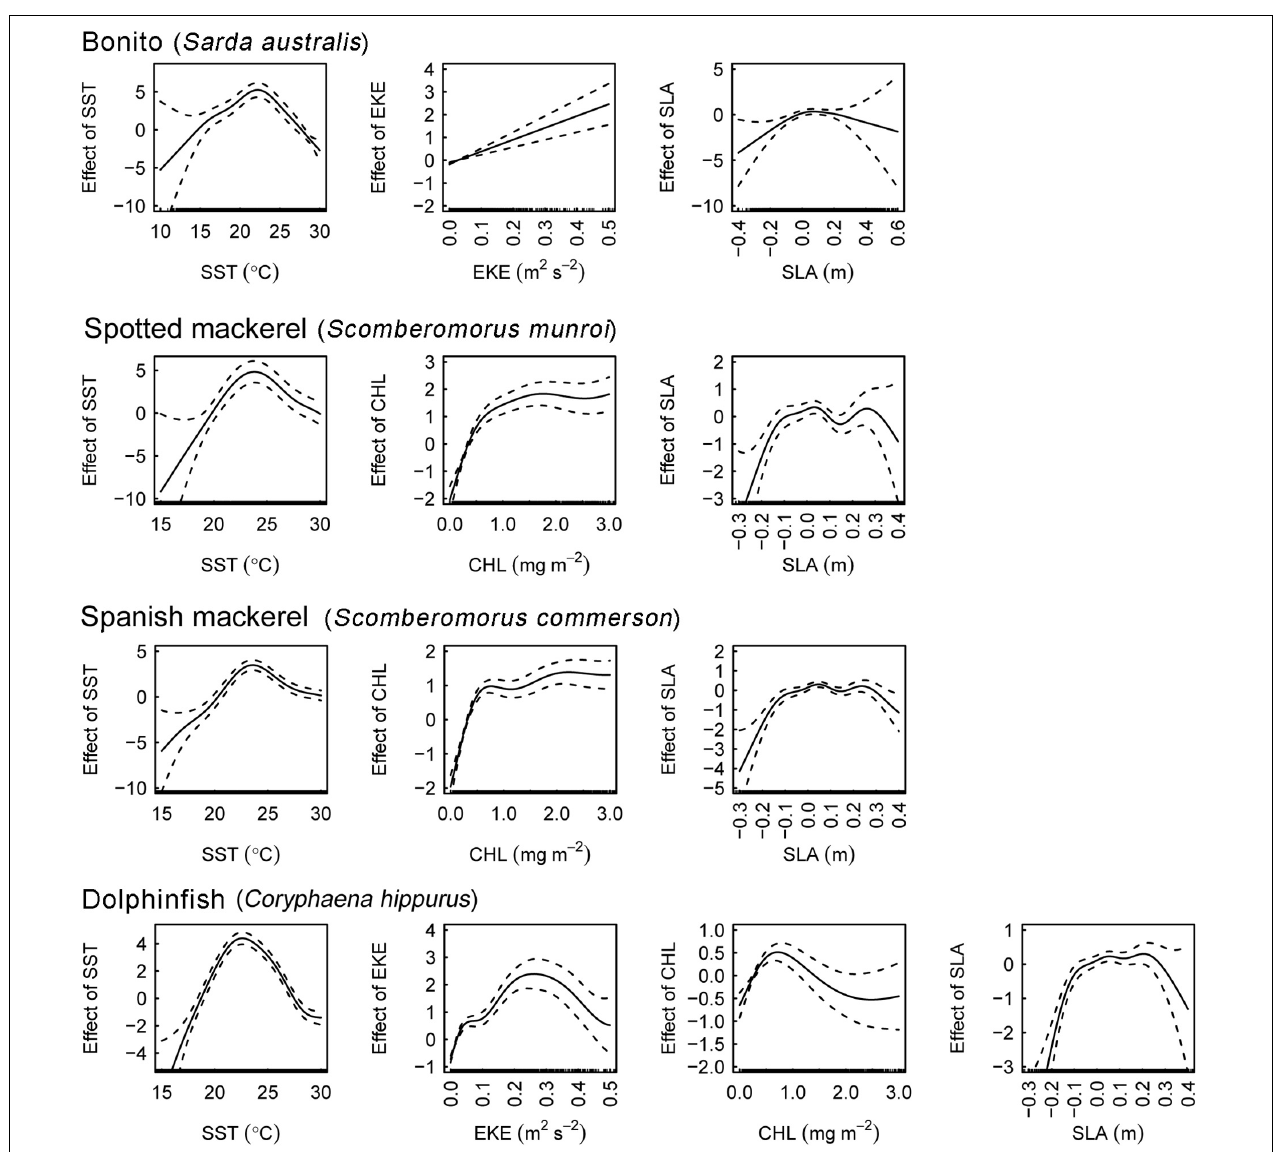
FIGURE 3 | Partial effects of covariates on the fitted values of the optimal bonito ( Sarda australis ), spotted mackerel ( Scomberomorus munroi ), Spanish mackerel ( Scomberomorus commerson ), and dolphinfish ( Coryphaena hippurus ) habitat suitability models. Dashed lines denote 95% confidence intervals. Rugs on x − axes indicate occurrence and pseudo − absence data for each covariate. SST, sea surface temperature; EKE, eddy kinetic energy; CHL, chlorophyll a concentration; SLA, sea level